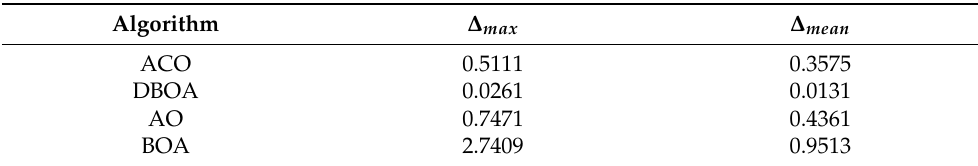
Table 2. Errors of reconstruction temperature function T in measurement points ( ∆ max —maximal absolute error; ∆ mean —mean absolute error).